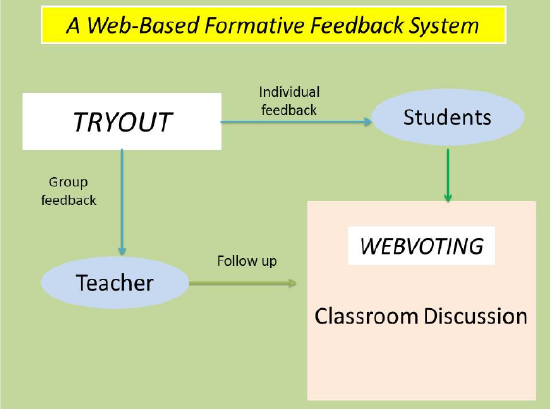
Figure 1. The Web-based Formative Feedback